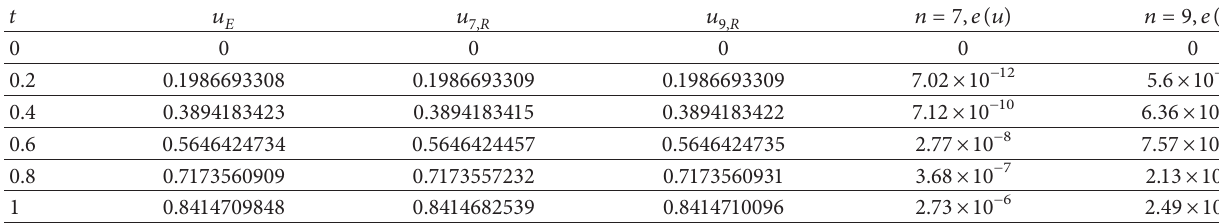
Table 2: Numerical result of Example 1.